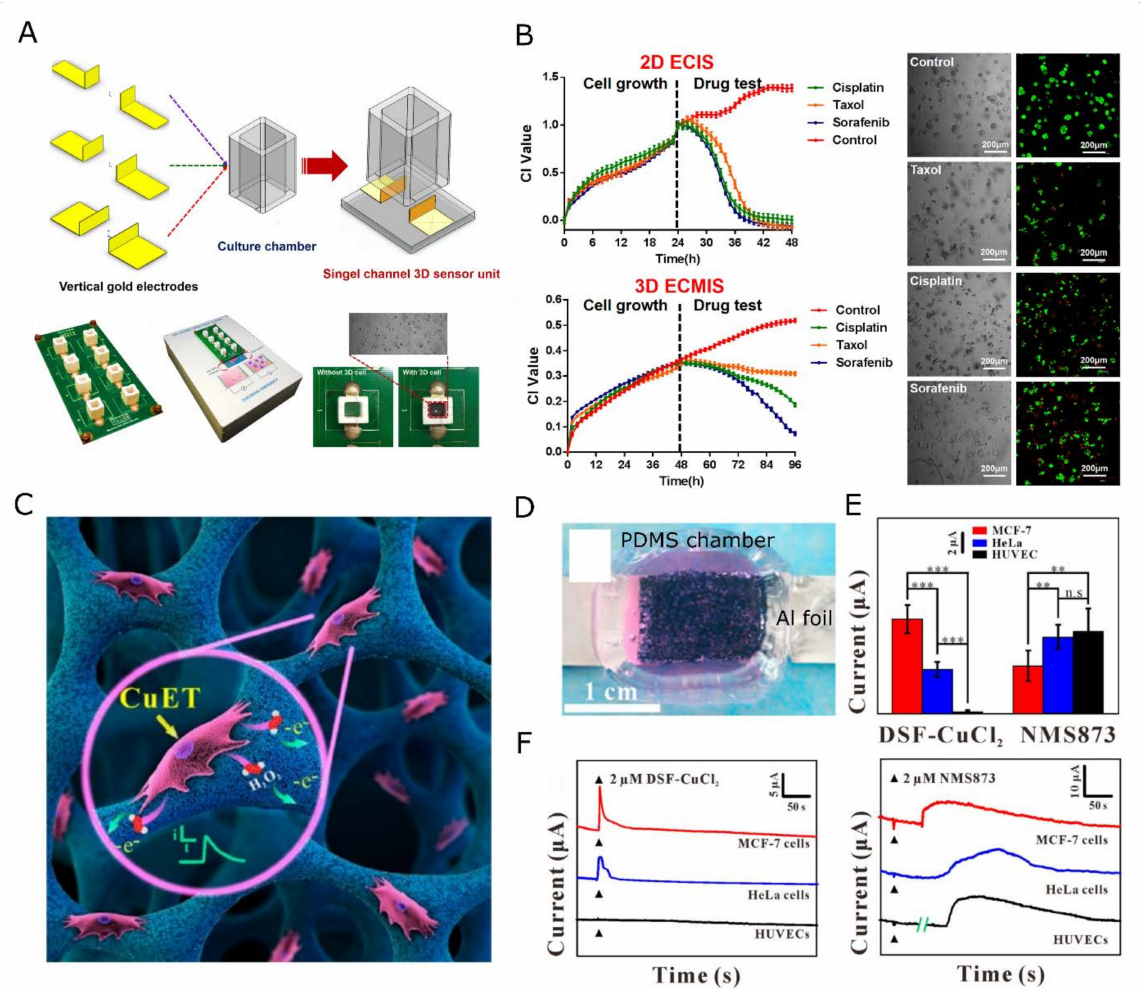
Figure 6. Electrochemical monitoring in 3D scaffolds. ( A ) Schematic representation of a 3D planar electrode impedance sensor for bulk monitoring of cell proliferation in 3D systems and ( B ) normalized cell growth curves as measured by 2D electric cell-substrate impedance sensing (ECIS) and 3D electric cell/matrigel-substrate impedance sensing (ECMIS) of 2D and 3D cultures of HpeG2 cells on top/within, treated with different 10 µ L of the anti-cancer drugs Cisplatin, Taxol and Sorafenib.